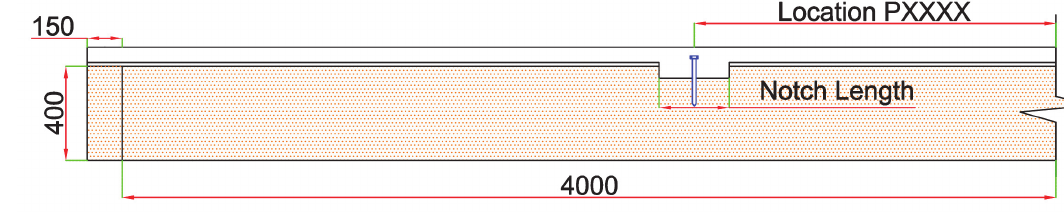
Figure 15: The parameters of this optimal study.